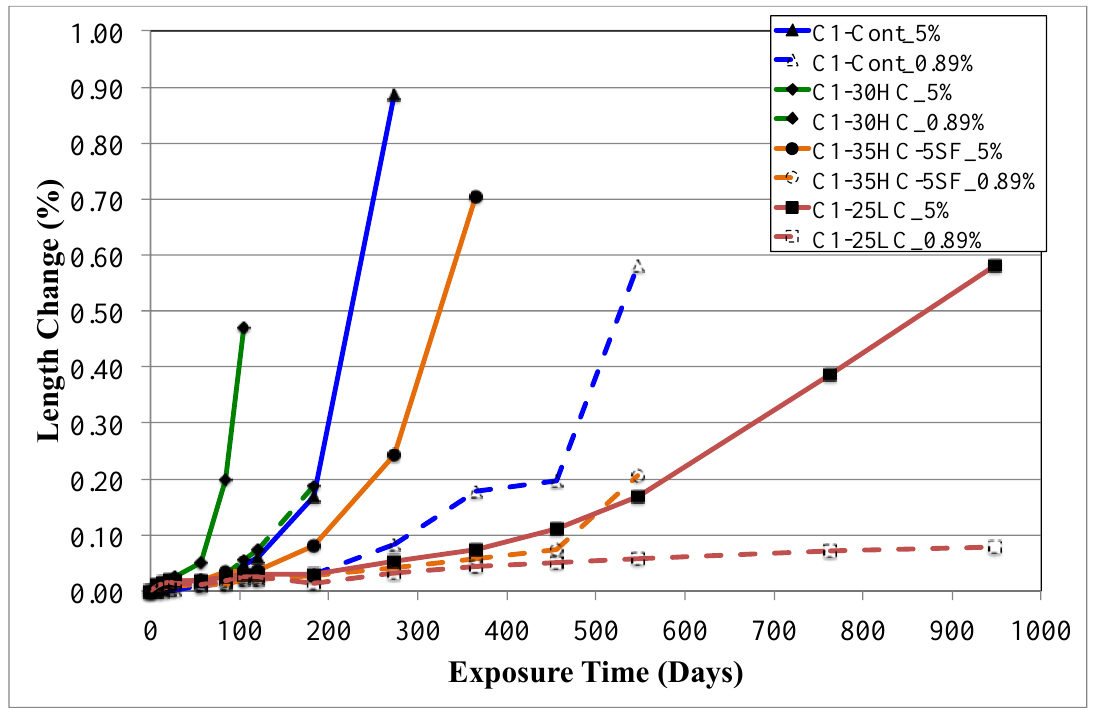
Figure 1. Accelerated mortar bar expansion results for Type I mixtures exposed to 5 and 0.89% Na 2 SO 4 .